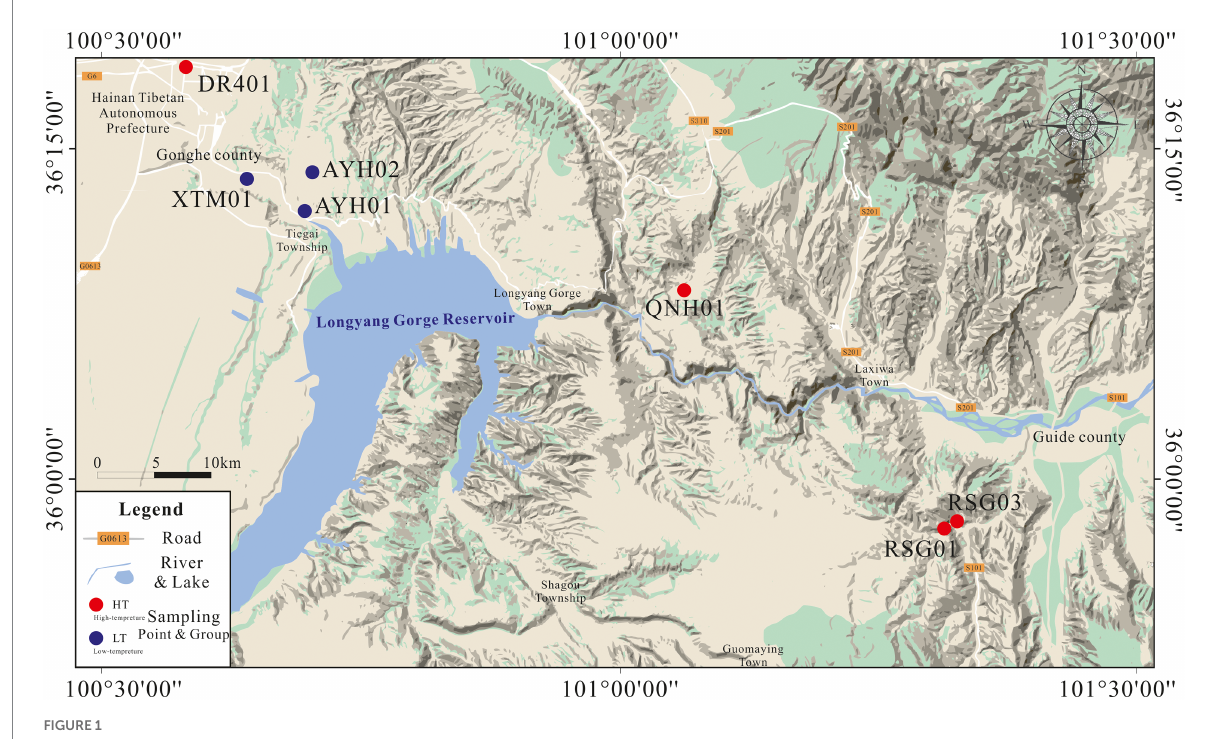
FIGURE 1 Geographical location and distribution of sample